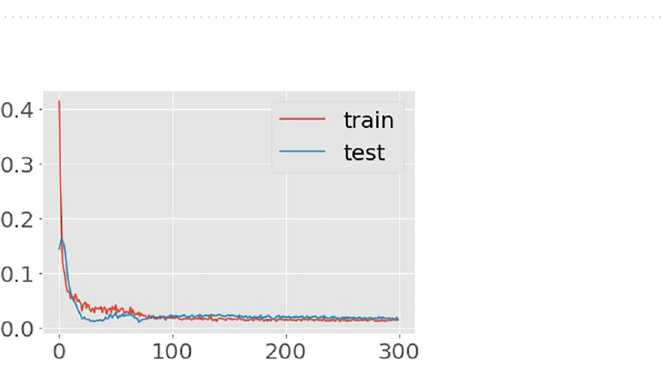
Figure 2. Learning curves of Autoencoder model (mRSS and WHO-FC ≥ II). Title = Autoencoder model loss. X-axis = Loss. Y-axis = number of epochs.